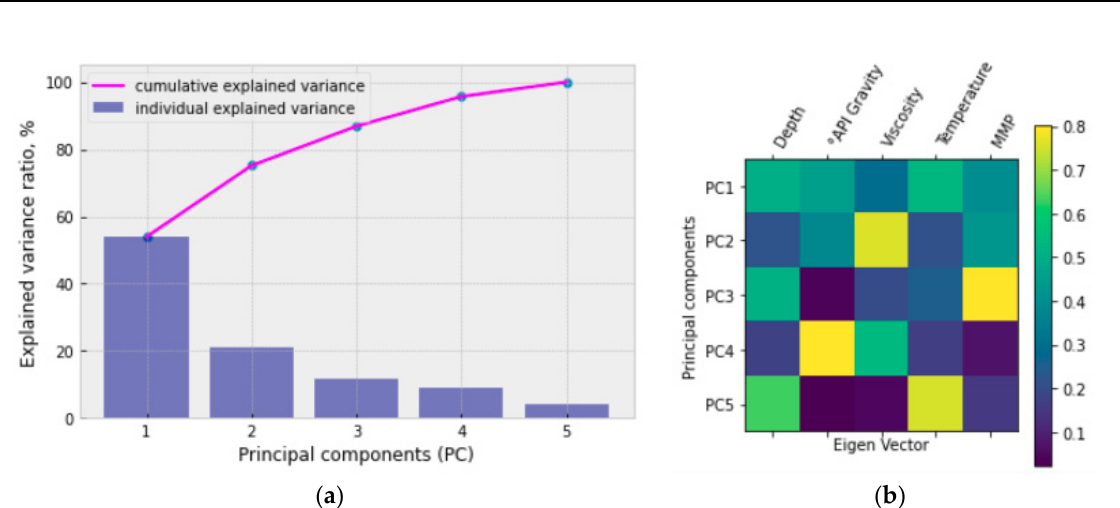
Figure 12. ( a ) Scree plot and ( b ) eigenvectors of PCA for immiscible CO 2 -EOR simultaneous screen- ing model A. Table 4. Summary of the immiscible CO 2 -EOR screening model.